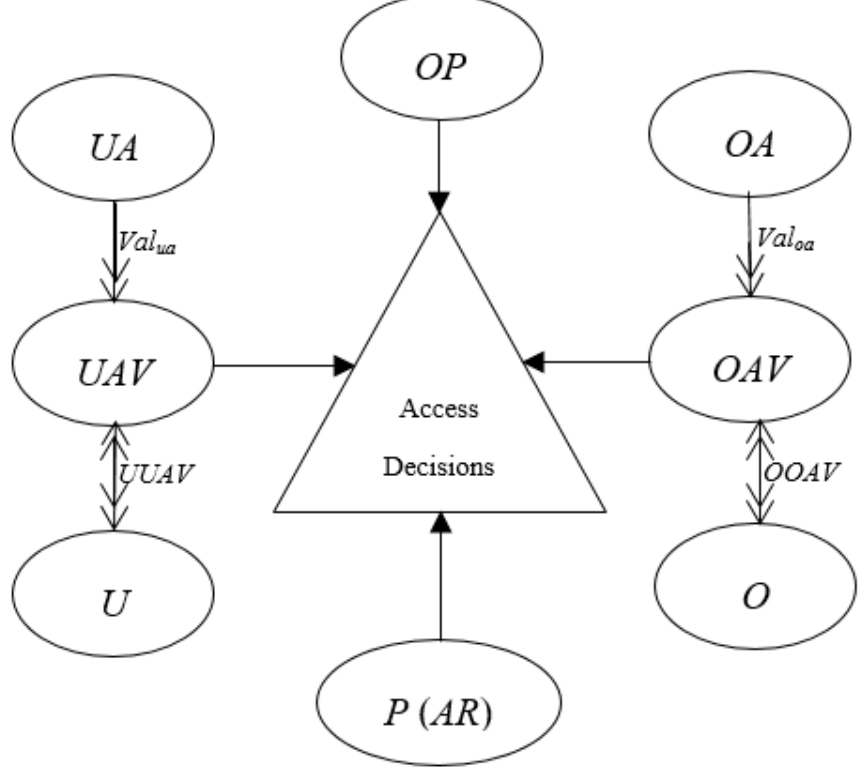
Figure 1. Factors influencing access decisions.